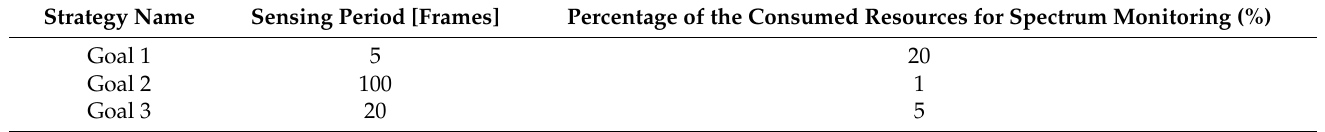
Table 1. Percentage of the consumed resources for different